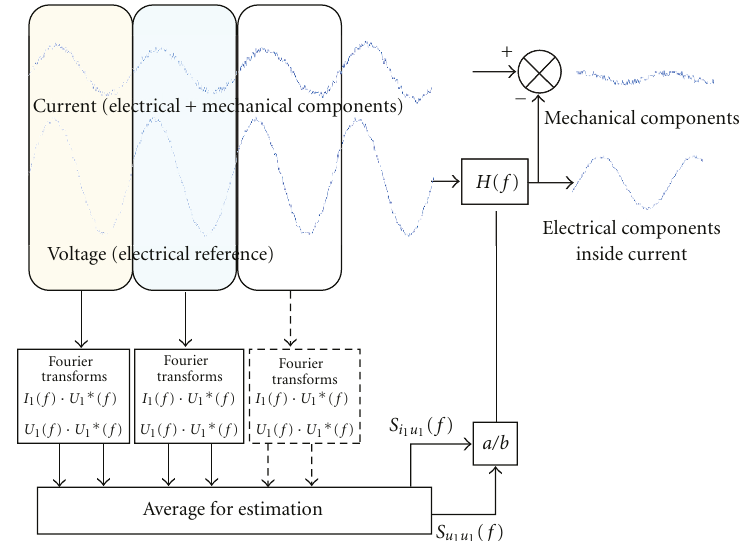
Figure 14: Spectrofilter.